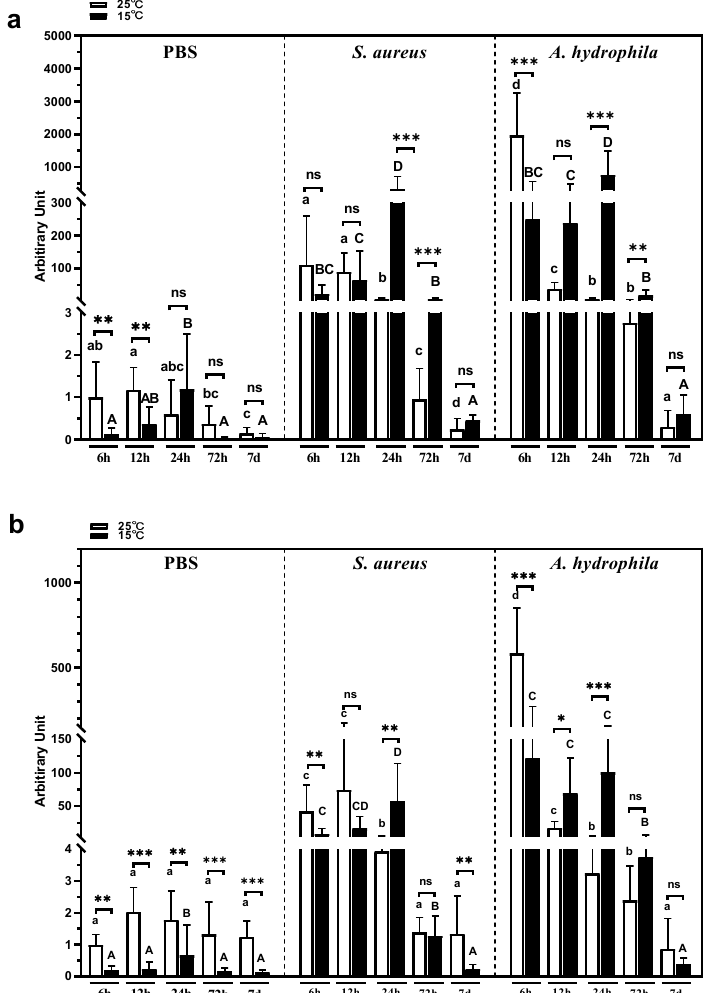
Figure 7. Expression of psiIL6 ( a ) and psIL6ns ( b ) in the spleen after S. aureus and A. hydrophila in vivo challenge within 7 days after cold stress. The relative expression method was applied in the calculation with ef1 α as the reference gene. The data are presented as mean + SD ( n = 6). Capitalized and small letters: Statistical comparison between time points within a treatment group. Different letter denotes statistically significant difference ( p < 0.05, capitalized vs. capitalized, small letters vs. small letters). ( a ) psIL6 and ( b ) psIL6ns expression. * p < 0.05; ** p < 0.01; *** p < 0.001. ns: No statistically